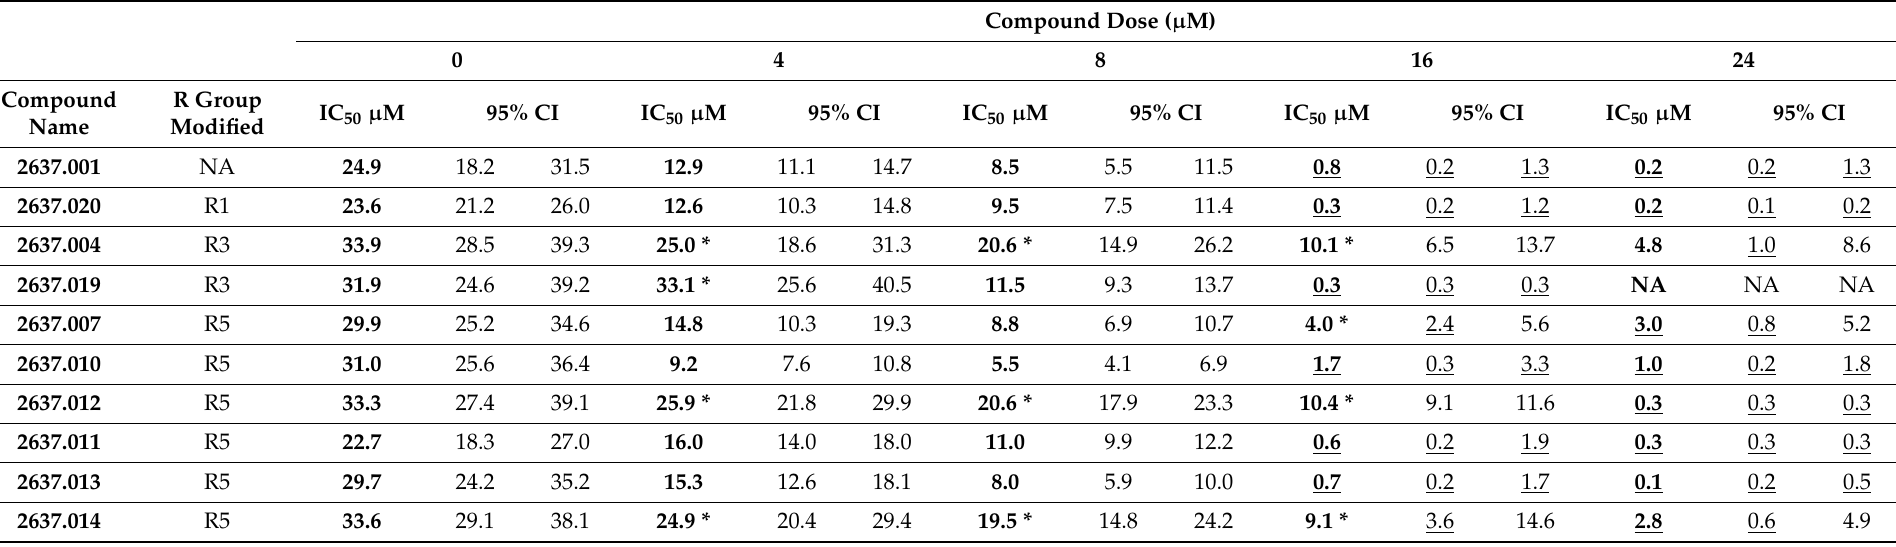
Table 2. Summary of checkerboard